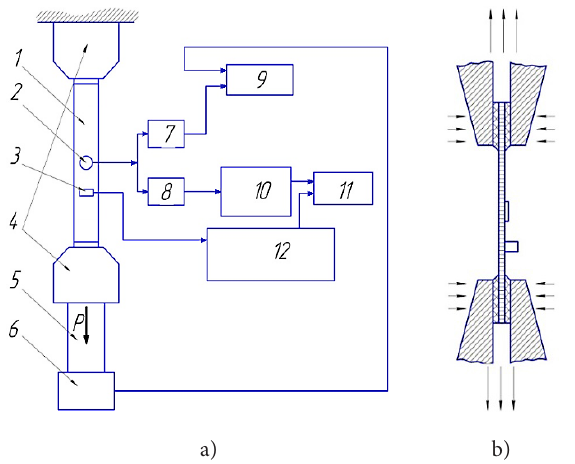
Figure 2. The switching circuit of the measuring complex (a), the clamping pattern of the sample (b): 1 – sample; 2 – acoustic emission sensor; 3 – strain gauge; 4 – clamp; 5 – loading system; 6 – dynamometer; 7 and 8 – preamps; 9 – acoustic emission device; 10 – acoustic emission device; 11 – a data collection card; 12 – strain gauge